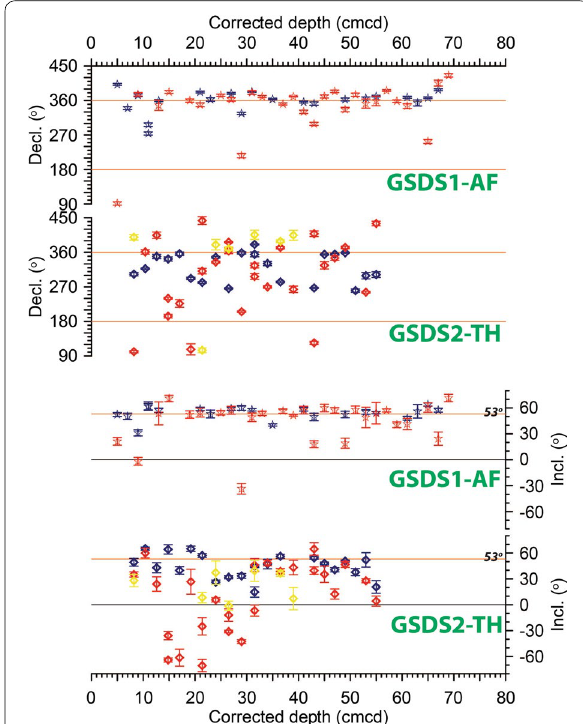
Fig. 12 AF‑derived declinations and inclinations of the PCA‑deter‑ mined remanence components in the GSDS1 profile and TH‑derived declinations and inclinations of the determined components in the GSDS2 profile, as a function of the corrected depth (cmcd, equivalent to the depth of the GSDS1 profile; see also Additional file 1: Table S3) by the rock magnetic GSDS1‑GSDS2 correlation as in Fig. 11. Blue, red and yellow symbols denote the direction data of the components, LFC1 or LTC1, HFC or HTC1, and HTC2, respectively (see text for details). Error bar for the individual data points indicates the calcu‑ lated MAD when applying the PCA. Note that direction data with MAD higher than 15° were not